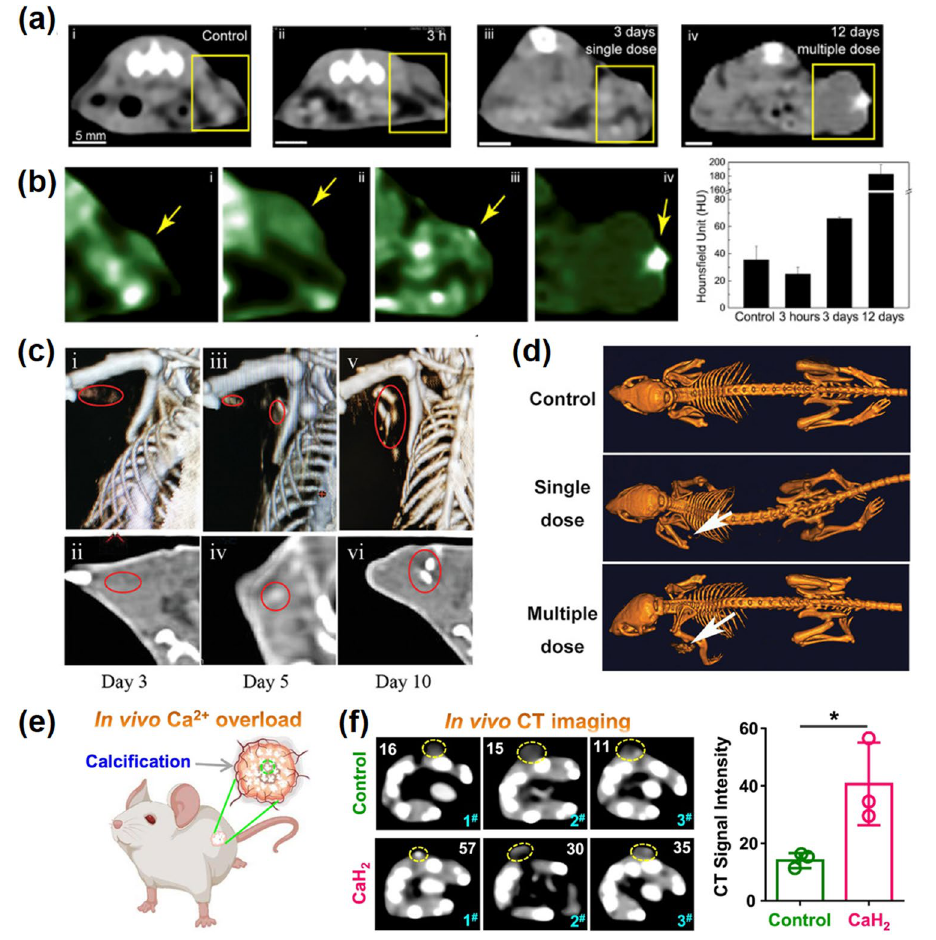
Fig. 14 Calcification-mediated cancer imaging. a CT images tumors treated with SH-CaO 2 NPs: (i) control, (ii) 3 h or (iii) 3 days after giving a single injection for a small tumor, (iv) 12 days after giving 4 doses for a big tumor. b Pseudocolor CT images of tumors (left panel) and their sta- tistic [28]. Copyright 2019, Elsevier. c CT images at 3, 5, and 10 days after UCRSPH + SA-CaO 2 + laser therapy [73]. Copyright 2021, Wiley– VCH. d CT images of mice in the control group, single dose group and multiple dose group after treatment [188]. Copyright 2021, Wiley–VCH. e Schematic diagram showing calcification induced by calcium overload after injection of nano-CaH 2 . f CT images of nano-CaH 2 -injected and the individual Hounsfield unit (HU) values [92]. Copyright 2022,